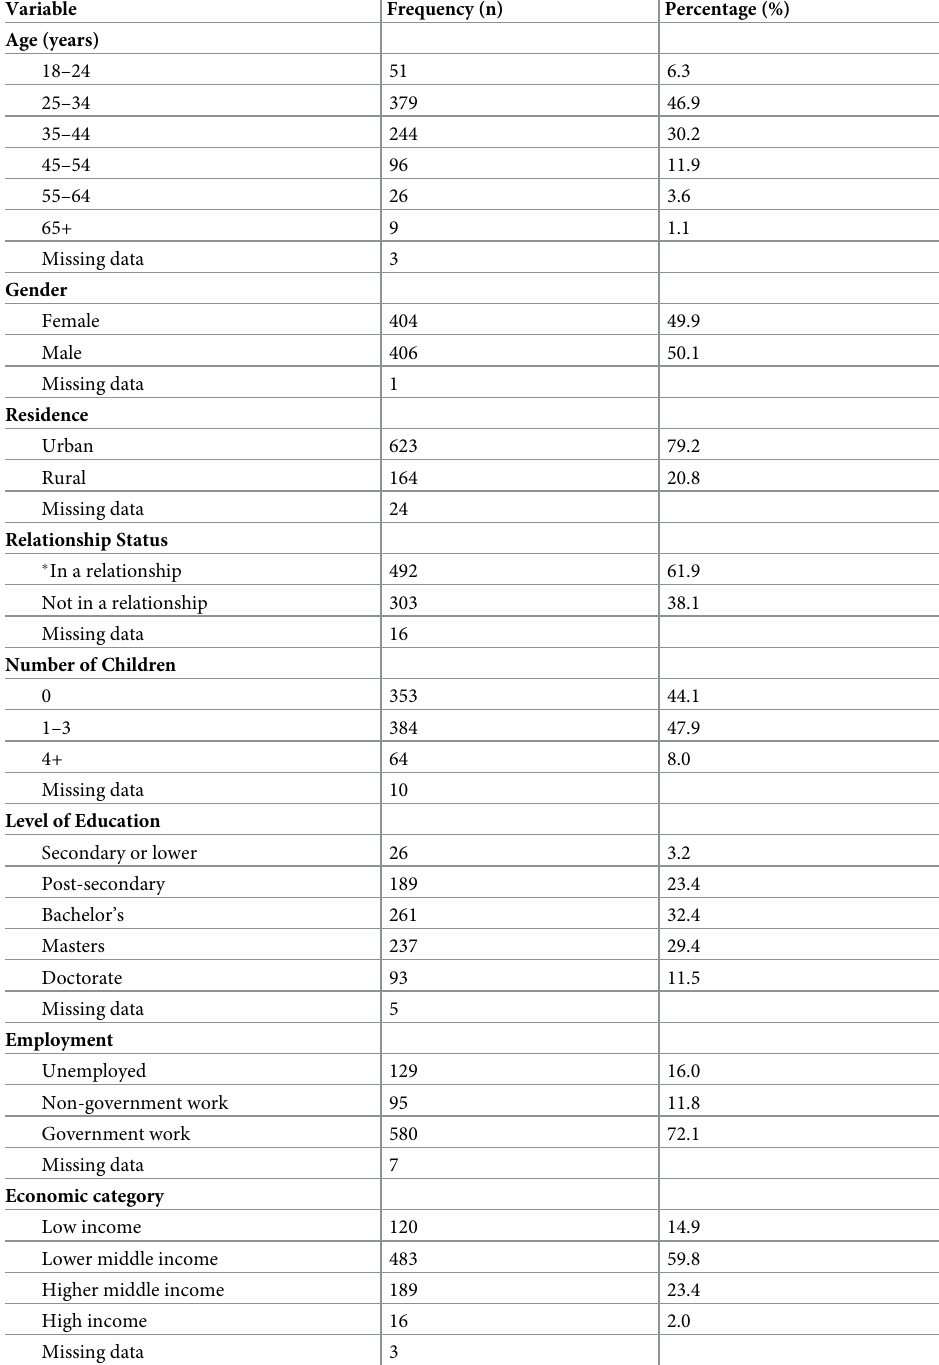
Table 1. Socio-demographic characteristics of participants (N =